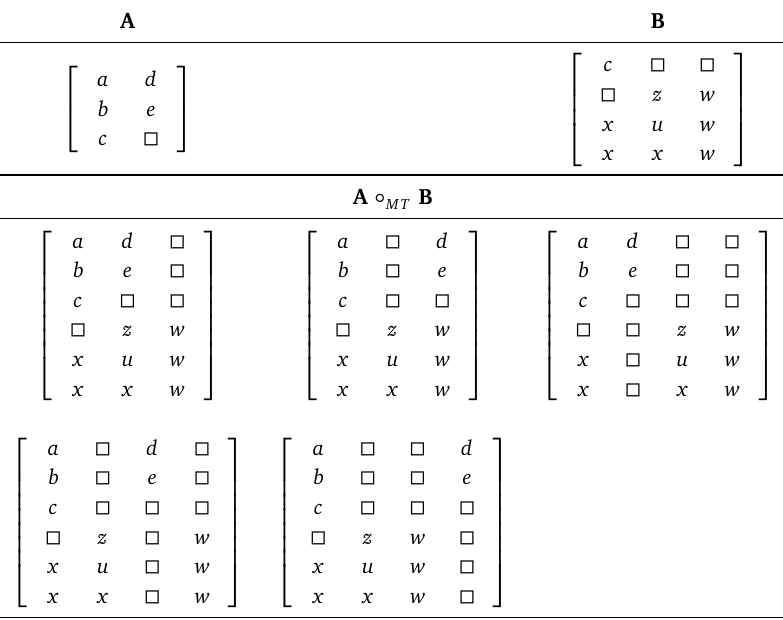
Figure 4: Composition of automata A and B , illustrating different alignments of epsilon-symbols. This shows composition behavior with respect to two particu- lar configurations in A and B . A subsequent filter, expressed as an automaton, removes all the solutions except the upper leftmost